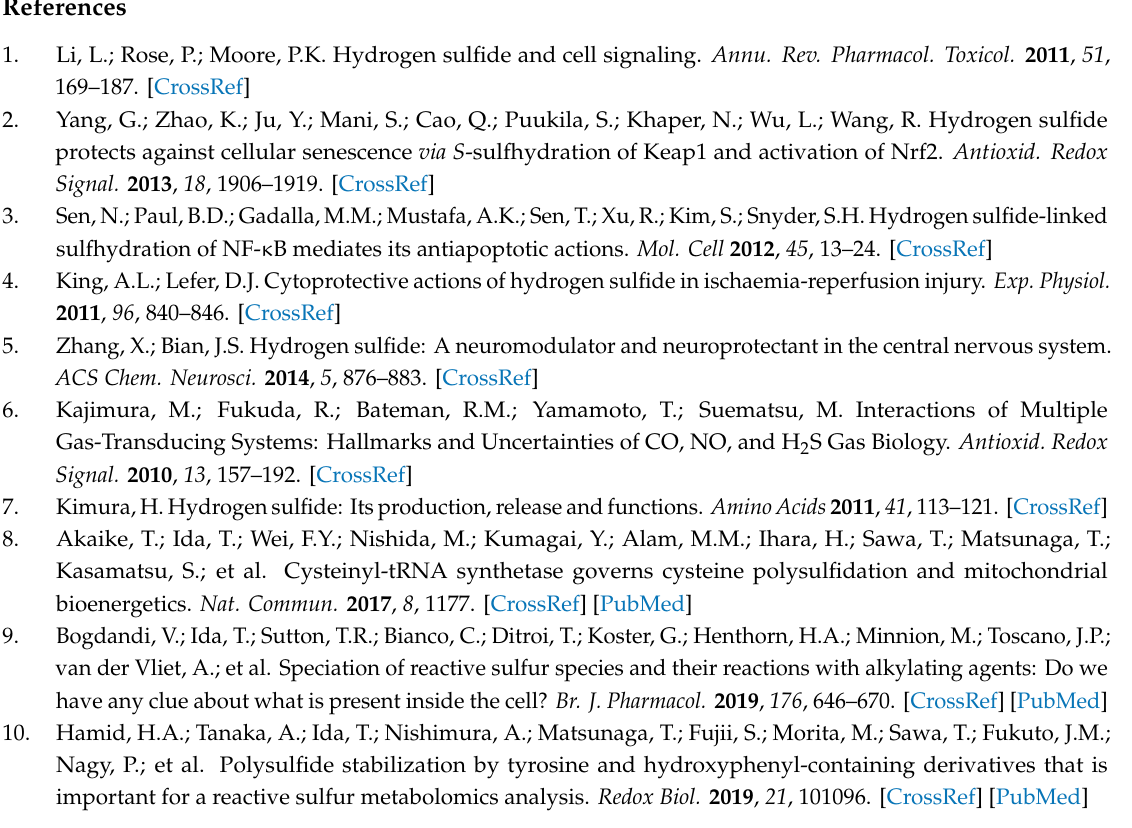
Figure S1: Preparation of NEM-S-NEM, Figure S2: Preparation of NEM-labeled cysteine, Figure S3: Detection of NEM-S-MPA-conjugated peptide fragments of NEM-S-MPA-conjugated BSA protein by LC-ESI-MS, Figure S4: Detection of NEM-S-MPA-conjugated peptide fragments of NEM-S-MPA-conjugated OVA protein by LC-ESI-MS, Figure S5: In vitro assay for stoichiometrical detection of NEM-S-NEM by competitive ELISA, Table S1: Multiple reactions monitoring conditions by LC-ESI-MS / MS for detection of NEM-S-adducts, Table S2: Selected ion monitoring conditions by LC-ESI-MS for detection of NEM-S-MPA-containing peptide fragments produced by chymotrypsin digestion of NEM-S-MPA-conjugated BSA and OVA proteins., Table S3: The exact values in original mouse plasma determined by competitive ELISA and LC-ESI-MS /